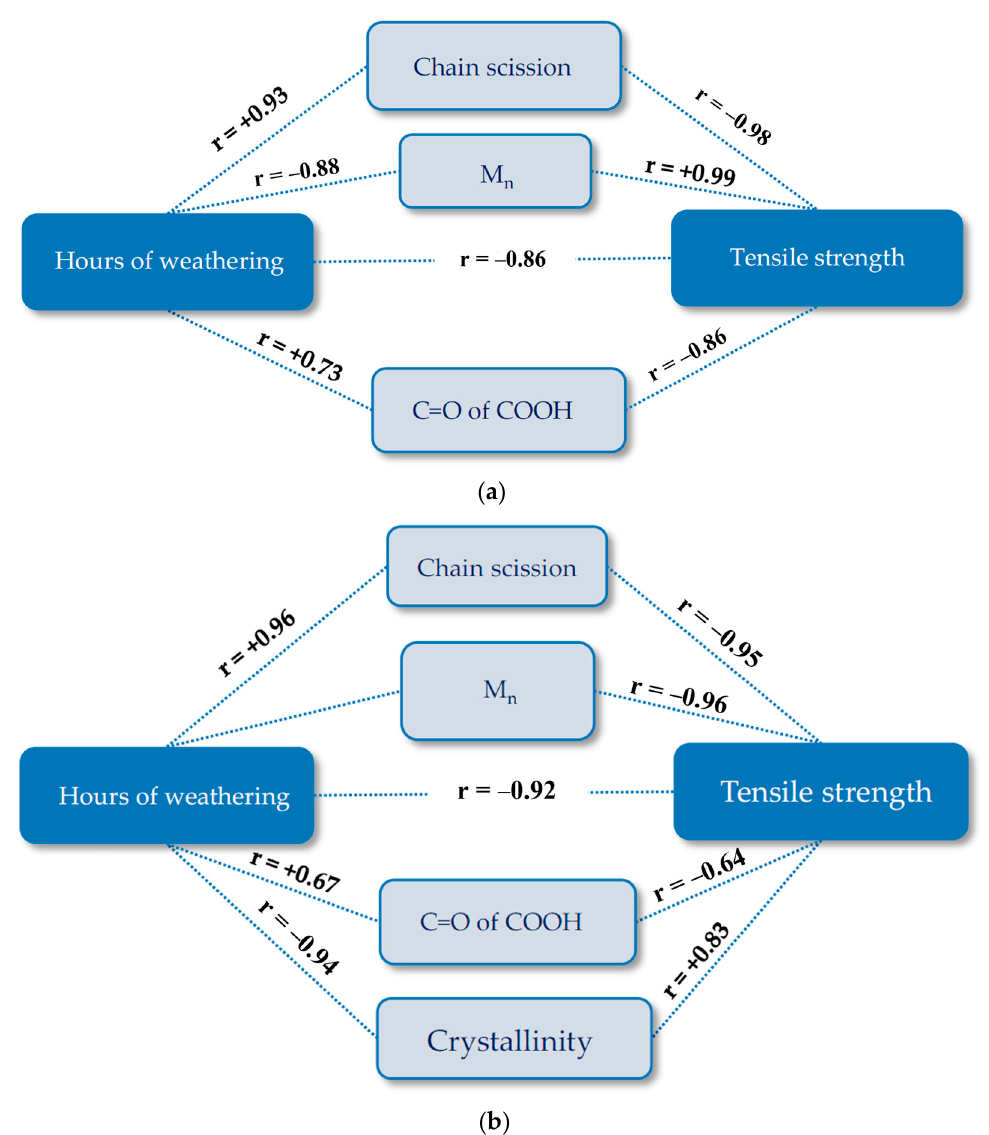
Figure 19. Pathway diagram for the tensile strength deterioration of uncoated PET Type II under artificial exposure (Method M4): ( a ) warp direction; and ( b ) weft direction. R, Pearson’s correlation coefficient; C=O of COOH of carboxylic acid (1688 cm − 1 ); crystallinity (1343 cm − 1 /1376 cm − 1 ).